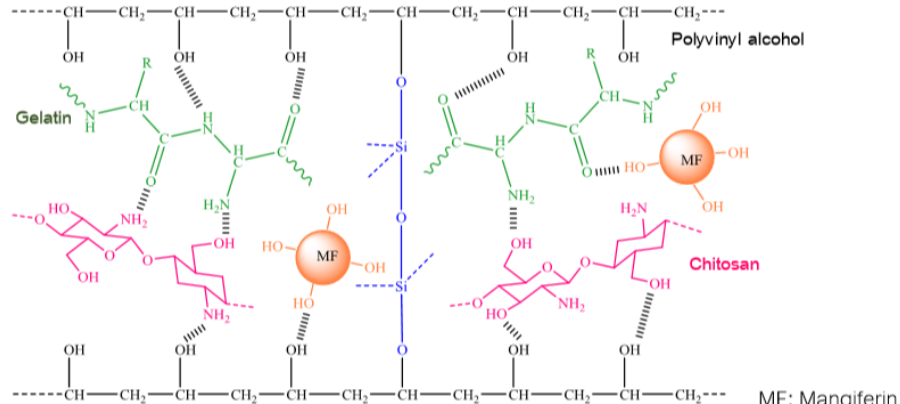
Figure 3. The proposed schematic illustration of intermolecular and intramolecular hydrogen bonding in mangiferin-loaded hybrid-ternary blend hydrogel [151].